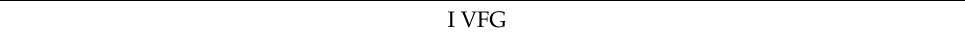
Table 1. Topic guide for virtual focus groups: facilitating elements and questions used to create discussion.